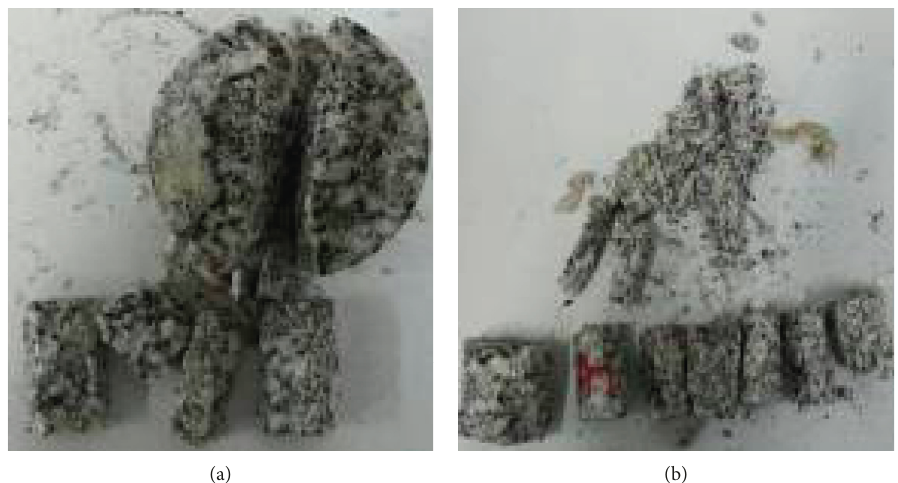
Figure 13: Failure forms of rock under different loading rates.